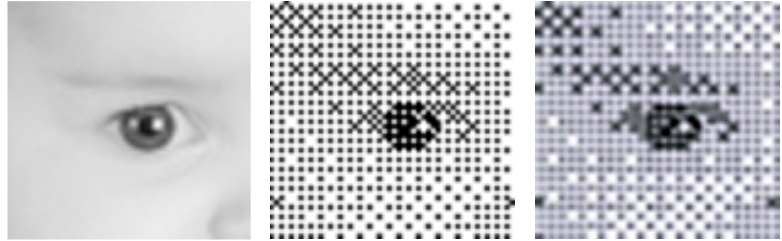
Figure 3. Color halftoning process. R, G, and B channels of RGB image; color halftone image; and continuous-tone image are shown from left to right in that order. Figure 4. Sample images showing continuous-tone image, digital halftone image, and scanned halftone image from left to right.